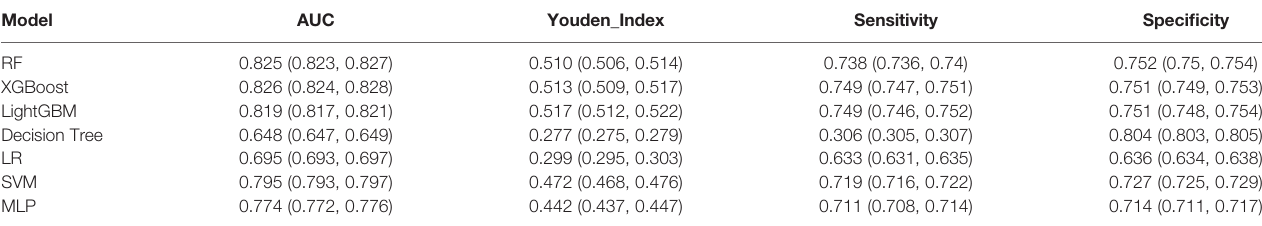
TABLE 2 | The quantitative performance and the ROC curves of included